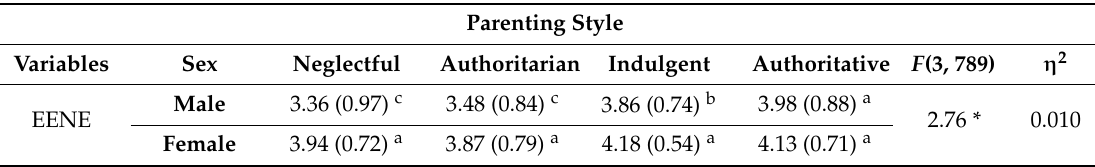
Table 5. Means (standard deviations), and main univariate F values for parenting style, gender and emotional empathy to natural environment.